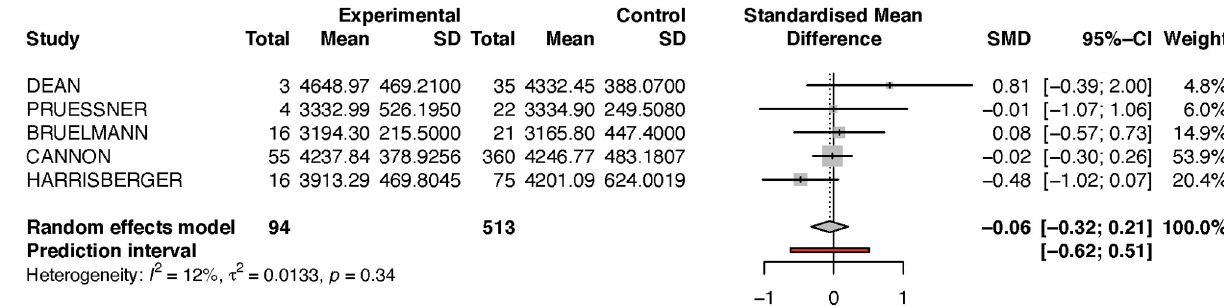
FIGURE 2 | Forest plot for Right hippocampus (full analysis).